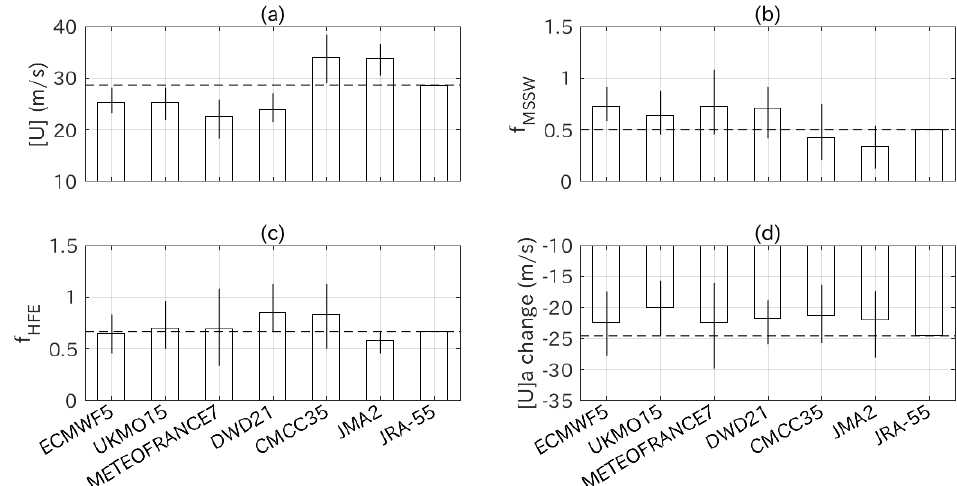
Figure 1. Bar charts of four quantities relevant for the stratospheric polar vortex for the HC and JRA-55 data: ( a ) climatological zonal mean zonal wind [U] at 60 ◦ N, 10 hPa, ( b ) frequency of MSSWs, ( c ) frequency of HFEs, and ( d ) mean time change in zonal wind anomalies [U]a from lag = − 10 to 0 day for the HFEs. Panel ( a ) takes DJF means of the zonal wind, whereas ( b , c ) deal with events during DJF and plot their frequencies per DJF season. Each bar plots the ensemble mean, and each vertical line plots the 99% range of the ensemble members. Horizontal broken lines plot the JRA-55 results. Square brackets denote the zonal mean, and subscript a denotes anomalies.